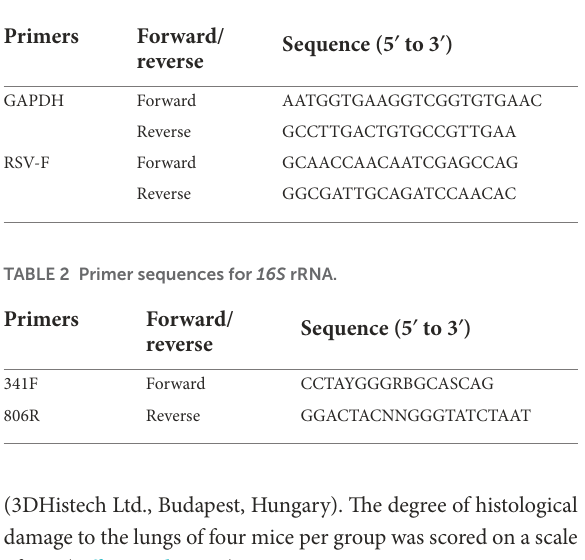
TABLE 1 Primer sequences for qRT-PCR.